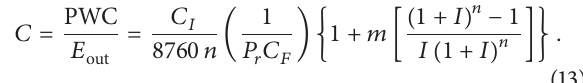
Figure 8: Total annual energy output from nominated wind turbines at Jarandagh